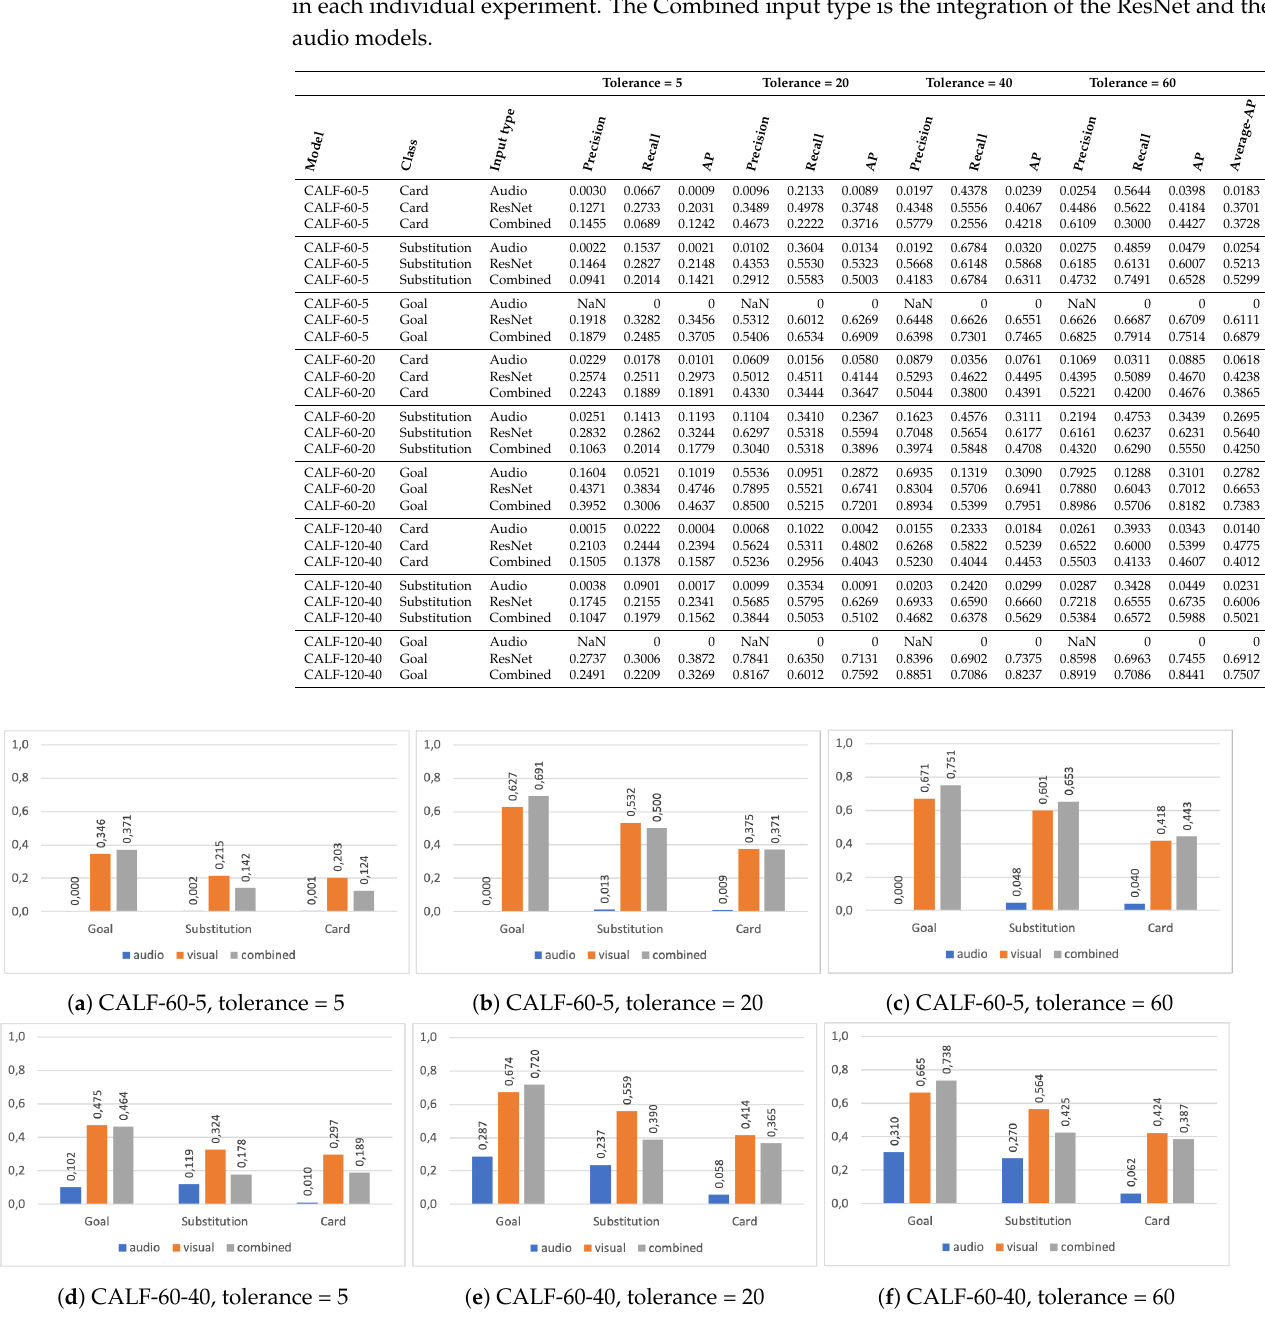
Figure 11. Spotting performance in terms of Average Precision per event type, for the CALF-60-5 and CALF-60-20 models over the tolerances 5, 20, and 60. In general, we can observe that for goals, adding audio information almost always improves performance. For other events, it depends on the configuration, but it seems like the more audio information is included, the better the results